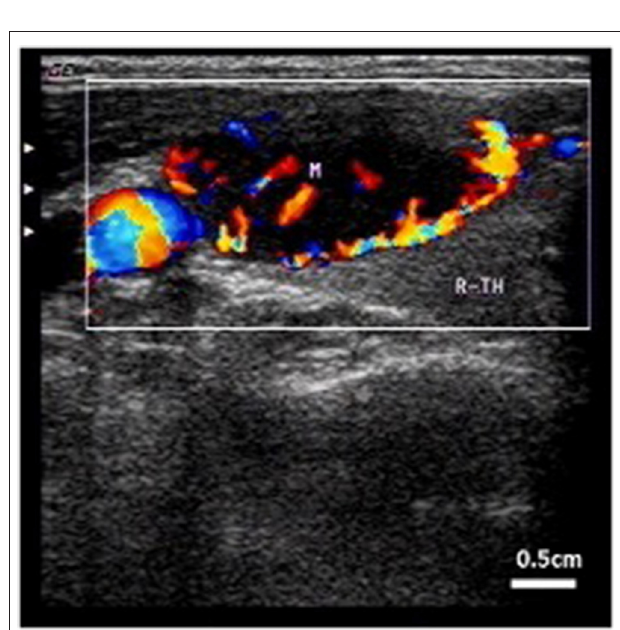
FIGURE 2 | Intracystic hemorrhage. Color blood flow can be observed by CDFI. Arrow indicates internal carotid artery.